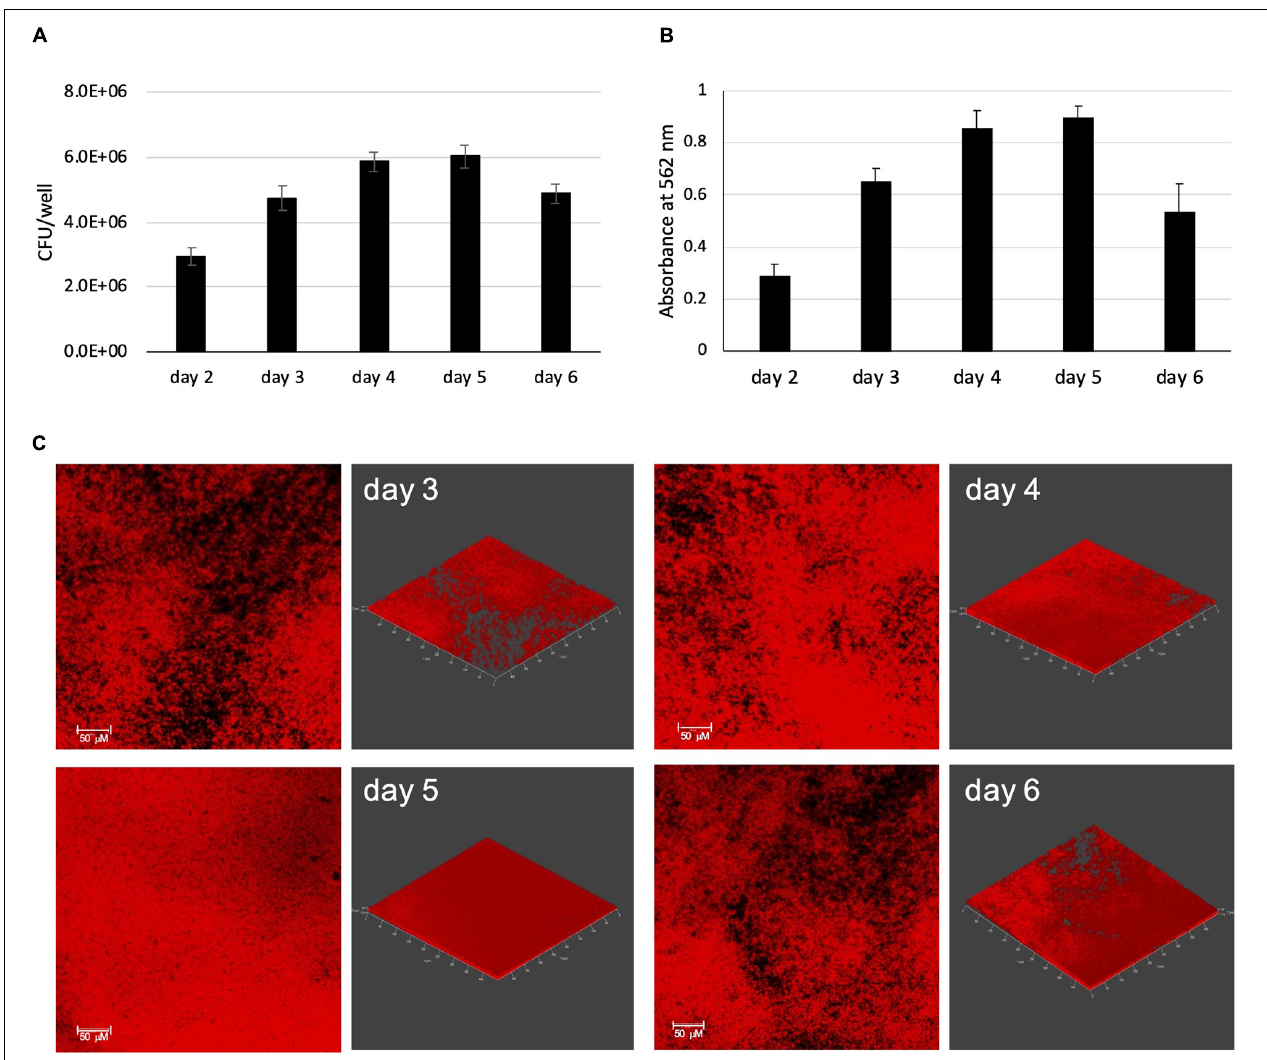
FIGURE 1 | MABSC biofilm formation in synthetic CF medium. Mabs NJH12 biofilm formation as monitored by CFU counting (A) and Crystal violet staining (B) . Shown are averages ± standard deviations of triplicate wells containing 200 µ L of SCFM. (C) Development of mCherry-expressing Mabs NJH12 biofilms as monitored by fluorescence confocal imaging. 2D (left panels) and 3D (right panels; X × Y × Z = 497 µ m × 497 µ m × 12 µ m) views of the biofilms are shown. The density of biofilms increases over time until they reach maturation on day 5 and start detaching from the substratum on day 6.